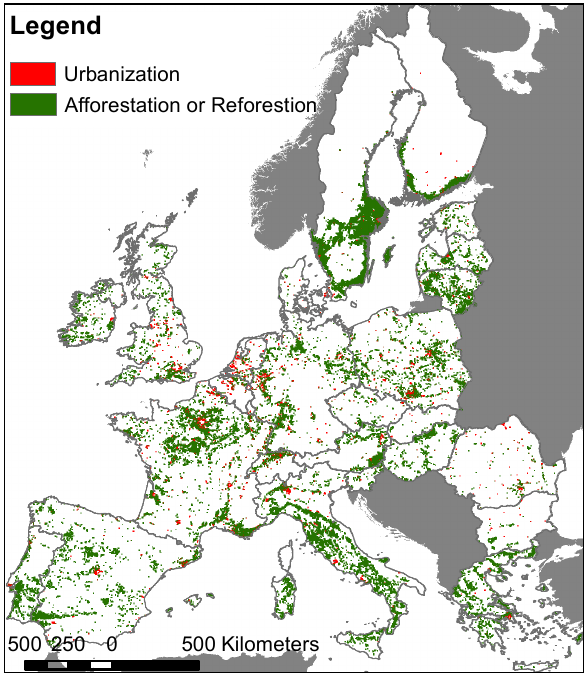
Fig. 10. Prime areas of major urbanization and afforesta- tion/reforestation hotspots for the period